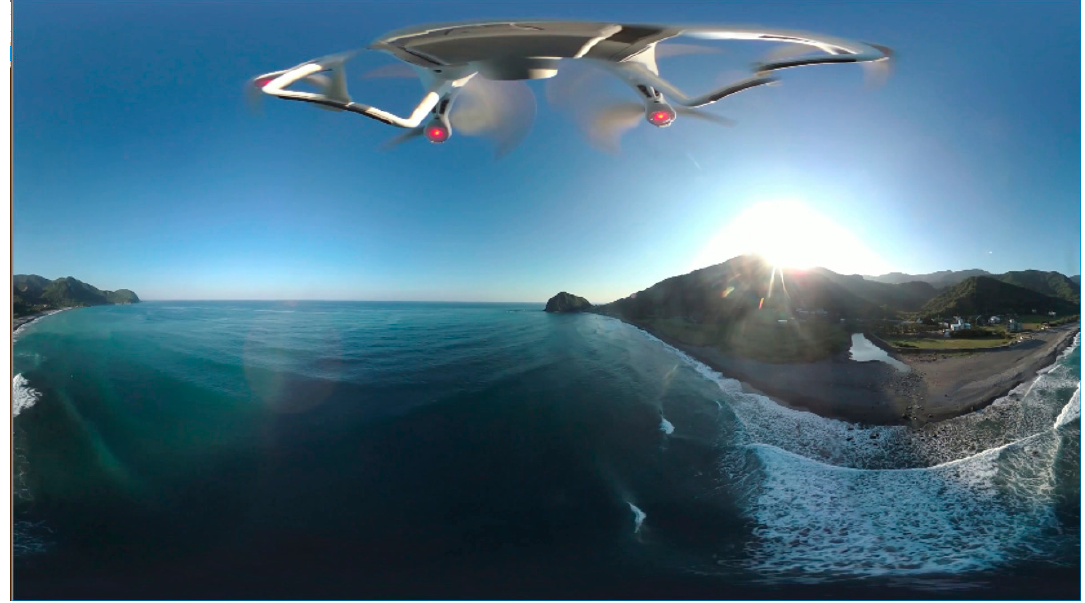
Figure 14. A typical example of 360-degree videos in an equirectangular format with several characteristics: seashore deformation, island scale change, building occlusion, mountain summit lighting change.